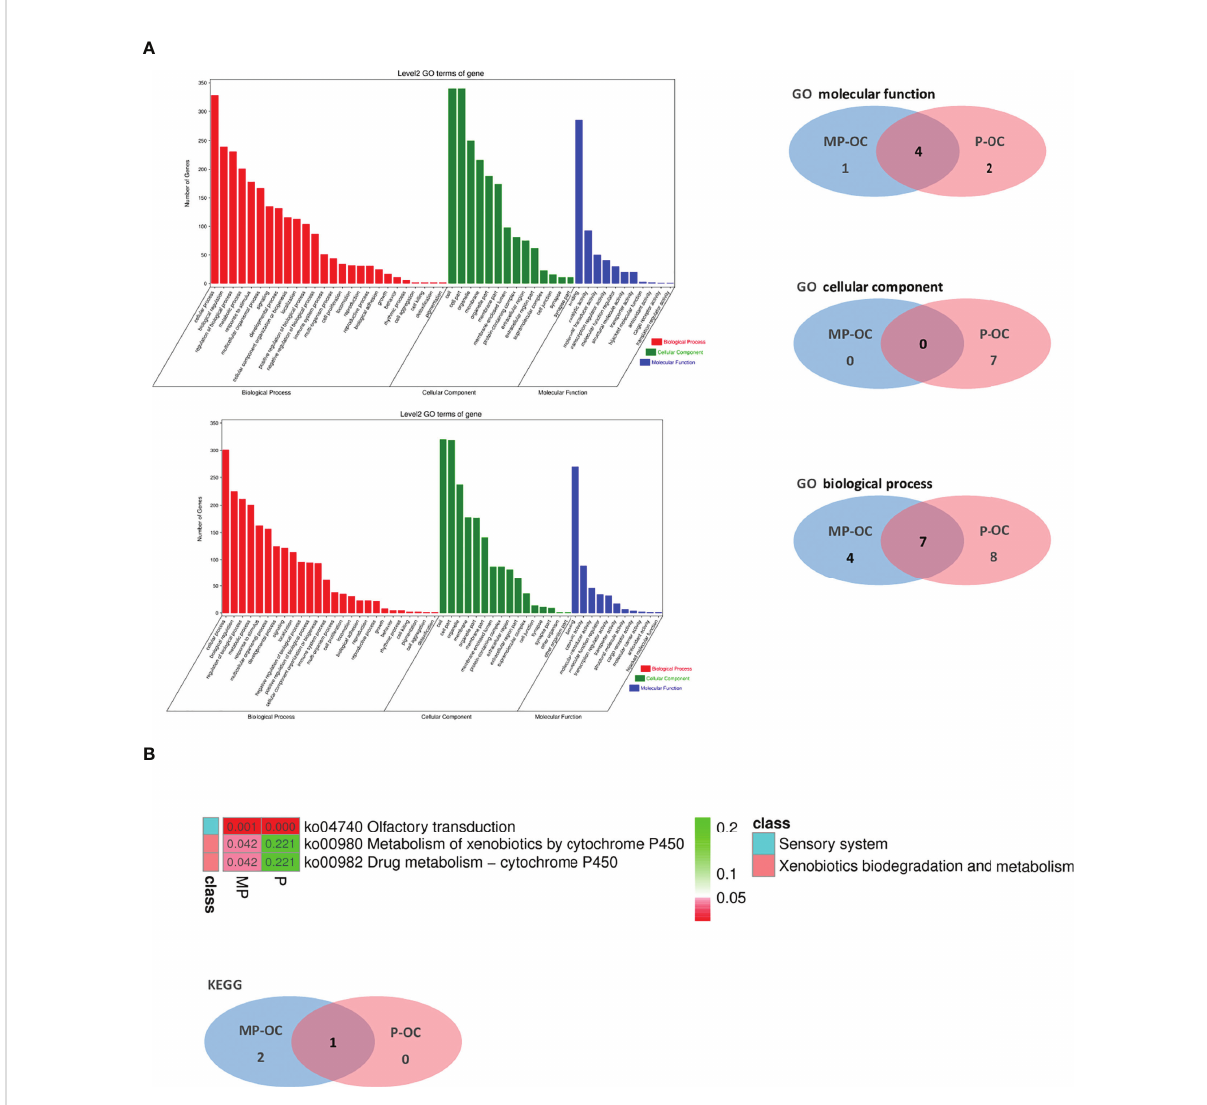
FIGURE 4 Pathway analysis of MP-OC and P-OC patients. Histogram showing the difference of GO between the MP-OC (upper) and P-OC (lower) group. Venn diagram showing the differences of molecular function, cellular component, and biological process in GO, respectively (A) . Lists of the signi fi cant KEGG pathways in the two groups. Wayne diagram showing the differences between the two groups (B)